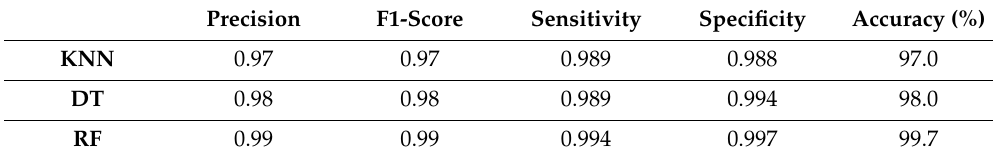
Table 6. The results of three classifiers in terms of six evaluation parameters. Precision F1-Score Sensitivity Specificity KNN